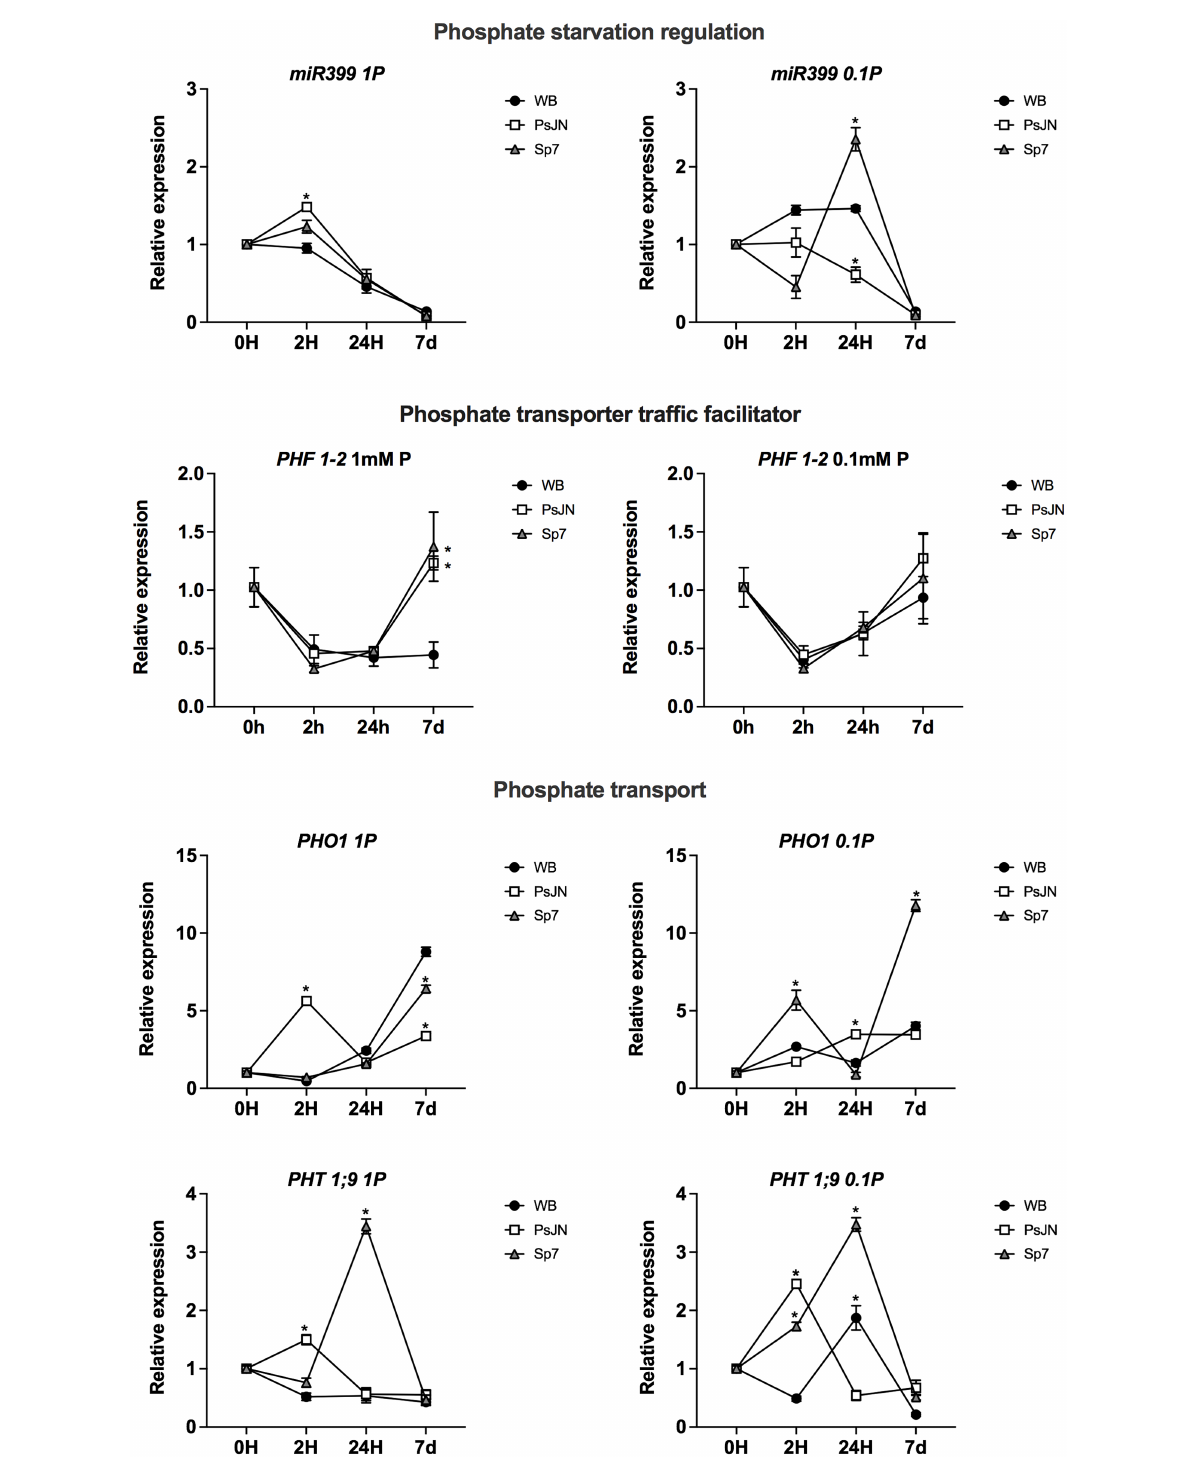
FIGURE 7 Effects of beneficial bacteria on phosphate response-related genes in Arabidopsis thaliana grown in different phosphate sources. Quantitative RT-PCR determinations of relative expression levels of the genes: PHR1-1 (PHOSPHATE STARVATION RESPONSE 1) ; PHL (PHR1-LIKE 1); PHF1-2 (PHOSPHATE TRANSPORTER TRAFFIC FACILITATOR 1) . Plants were exposed to 1 mm KH 2 PO 4 /0 mM Ca 3 PO 4 (Left panel) or 0.1 mm KH 2 PO 4 /0.99 mM Ca 3 PO 4 (right panel) for 0, 2, 24 h or 7 days (d). Simultaneously, plants were non-inoculated (WB) or inoculated with Paraburkholderia phytofirmans PsJN (PsJN) or Azospirillum brasilense Sp7 (Sp7). Normalization was performed with the housekeeping SAND family gene (AT2G28390). Asterisks indicate statistical significance among treatments in a particular time compared to the WB group (Two-way ANOVA and multiple comparisons, p <